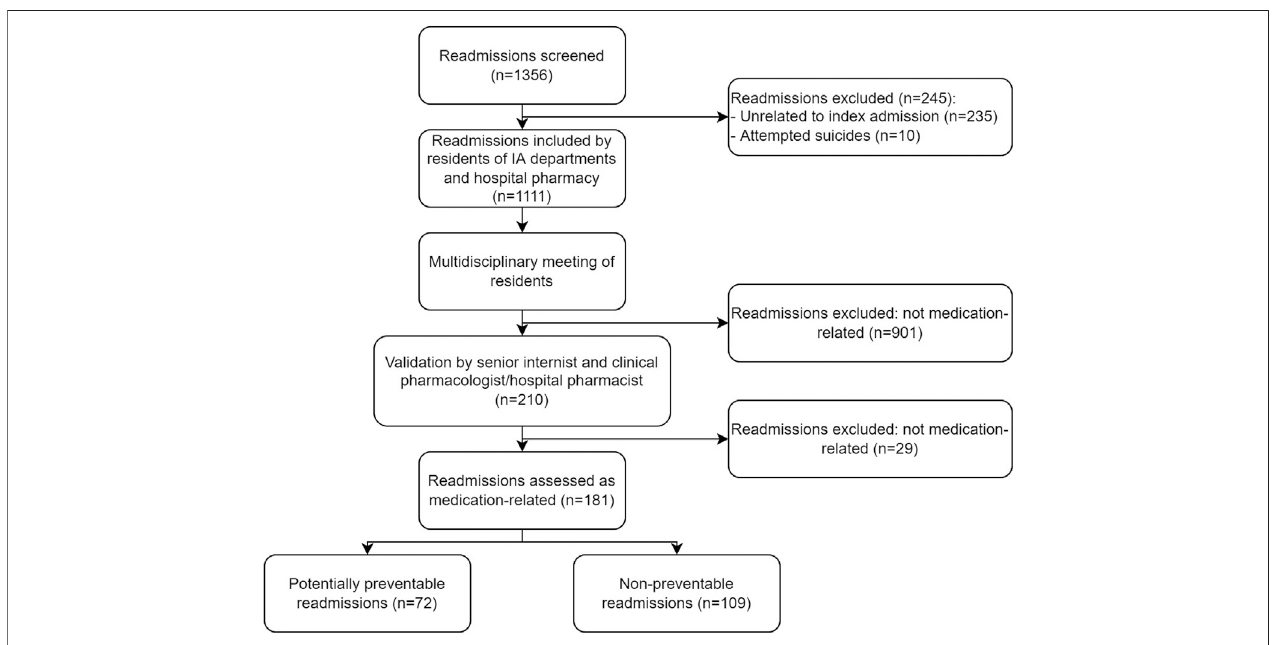
FIGURE 2 | Patient selection for the current